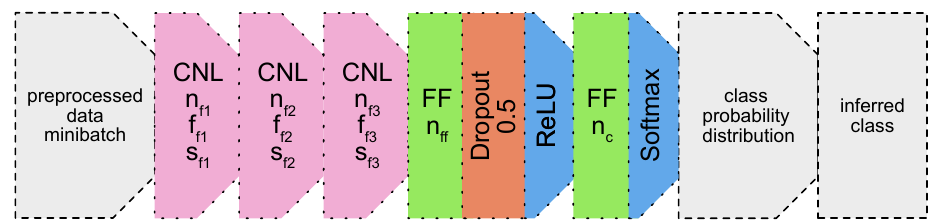
Figure 4. CNN DNN with three 2D convolutional layers (CNL) at its core. FF marks a typical fully-connected (dense) layer. n is number of filters or hidden units, f is 2D filter dimensions and s is stride of the filter for the respective